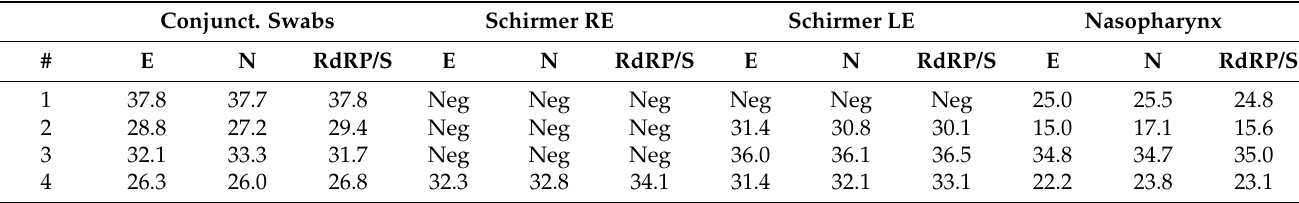
Table 2. Cycle threshold (Ct) values of the RT-PCR assay for each patient samples/genes studied. Conjunct. Swabs Schirmer RE Schirmer LE